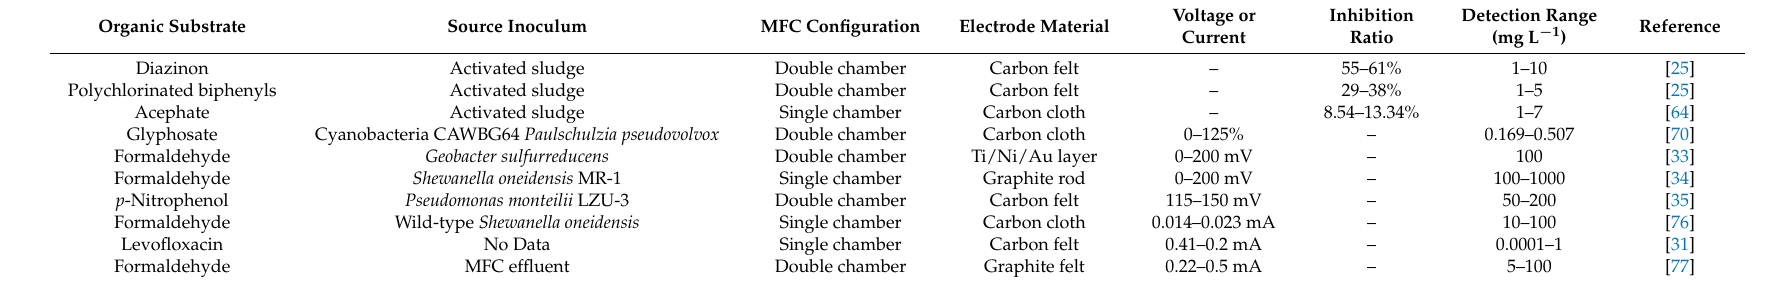
Table 3. MFCs as organic toxin